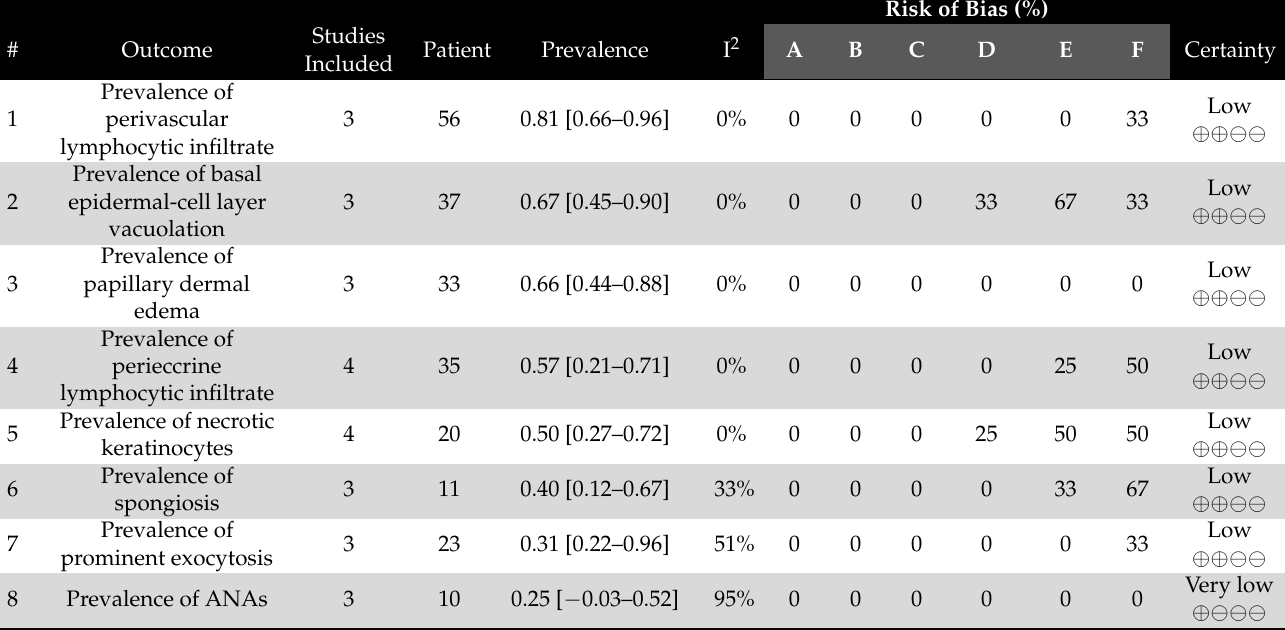
Table 3. Results for the eight random-effects meta-analyses assessing the prevalence of seven histopathological features and one serologic finding in patients diagnosed with chilblains. Detailed results are provided in the Supplementary File S1. Risk of Bias